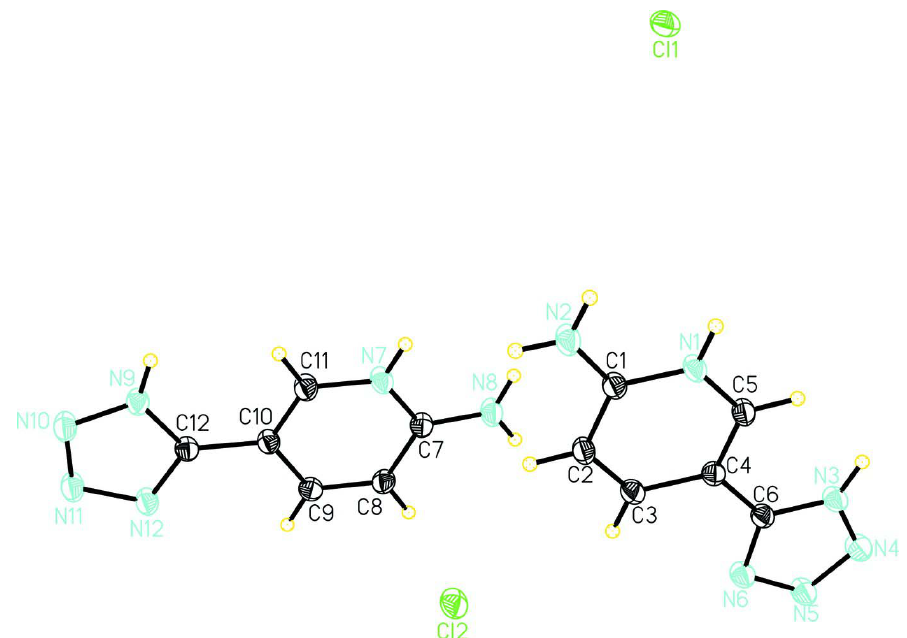
Figure 1 A view of the title compound with the atomic numbering scheme. Displacement ellipsoids were drawn at the 30% probability